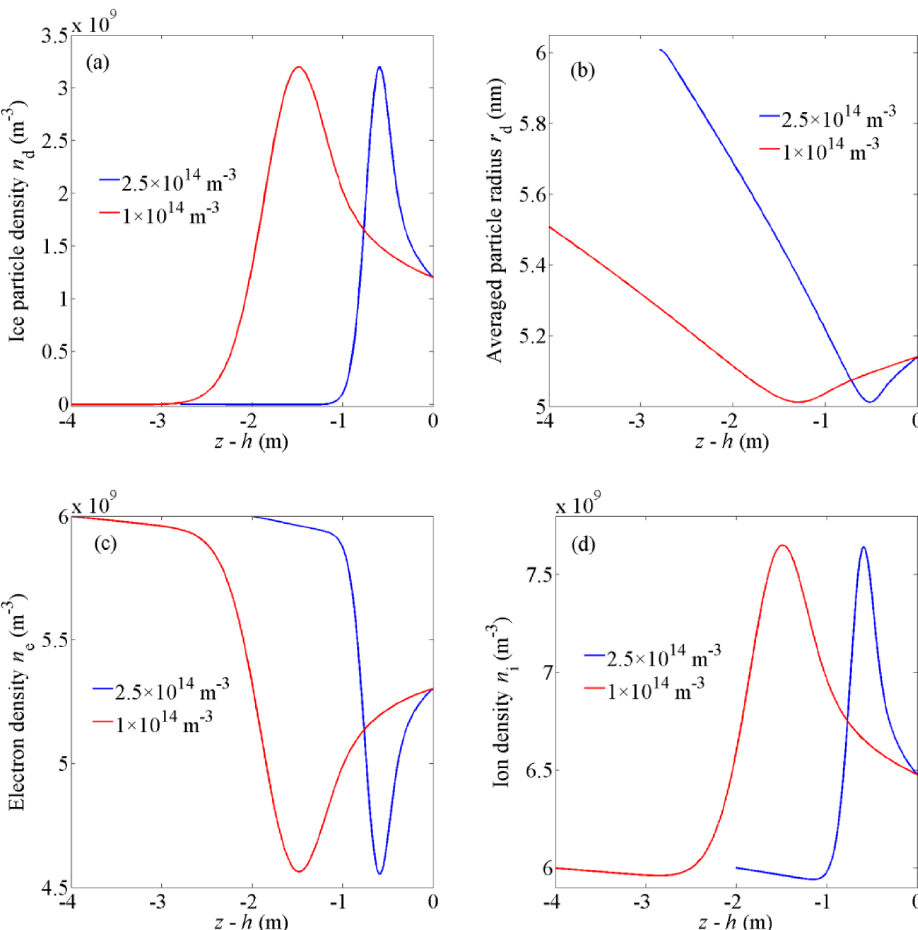
Figure 10. The distribution of (a) ice particle density, (b) the averaged particle radius, (c) electron density, and (d) ion density for various water vapor densities near the upper boundary of the condensation